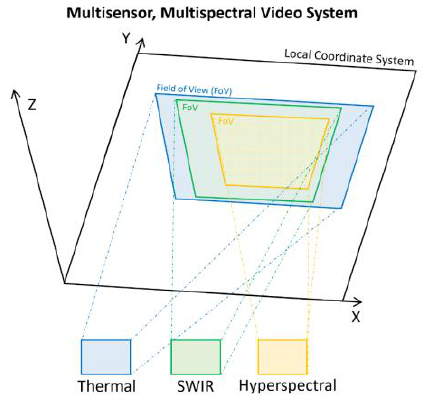
Figure 1: The main three sensors of the multisensor system and their corresponding field of view (FOV) on the region of interest (ROI). The ROI plane is associated with an arbitrarily defined, local coordinate system